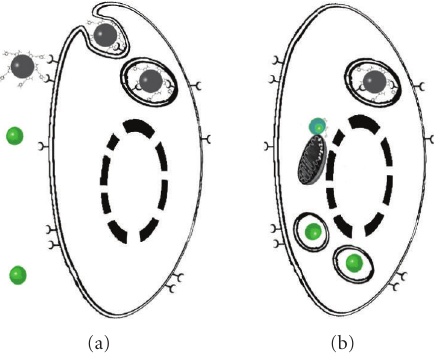
Figure 8: Fluorescent tracking of QD uptake and breakdown in cells (cellular structures not to scale). (a) QDs conjugated to an electron donor can bind to specific receptors (gray sphere) but are not immediately fluorescent. QDs that have lost this surface cap are immediately green-fluorescent (green spheres) but do not bind to receptors and are rarely endocytosed. (b) Processing through the cell leads to changes in surface cap and resulting alterations of flu- orescence. Areas of normal cellular redox potential such as endo- somes (gray) are not fluorescent unless illuminated for significant amounts of time. Highly oxidizing areas such as lysosomes, in con- trast, show immediate green fluorescence and no blue fluorescence without photoenhancement, indicating that the conjugate has been removed from the particle, probably due to proteases in the lyso- some. Particles near mitochondria show varying degrees of green and blue fluorescence with slow